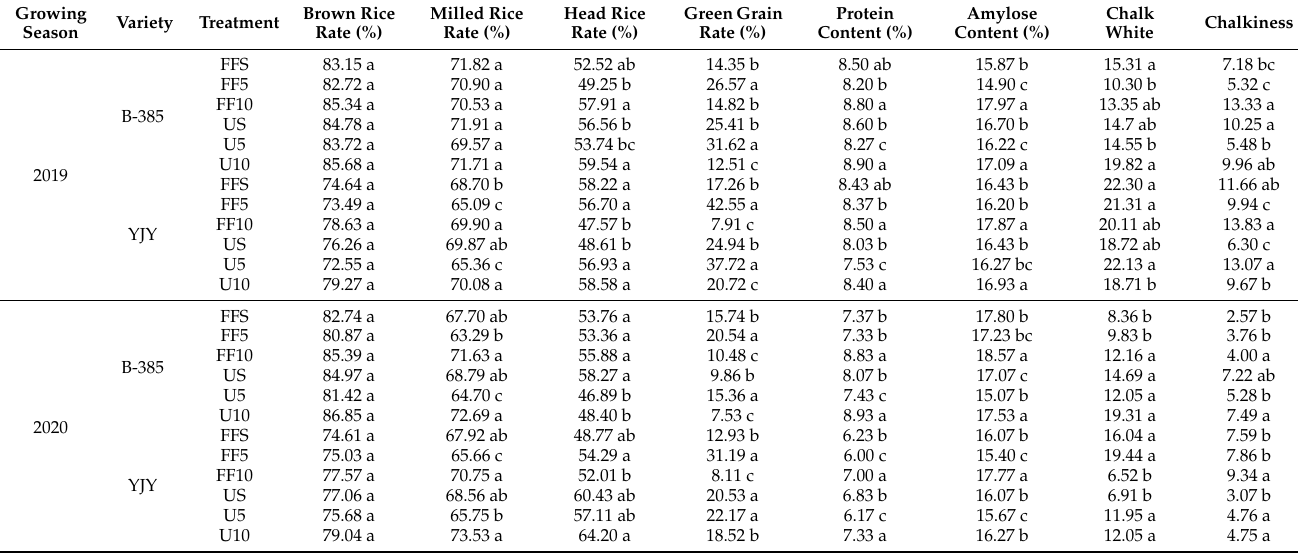
Table 4. Effects of different placements of fertilizers on rice quality.